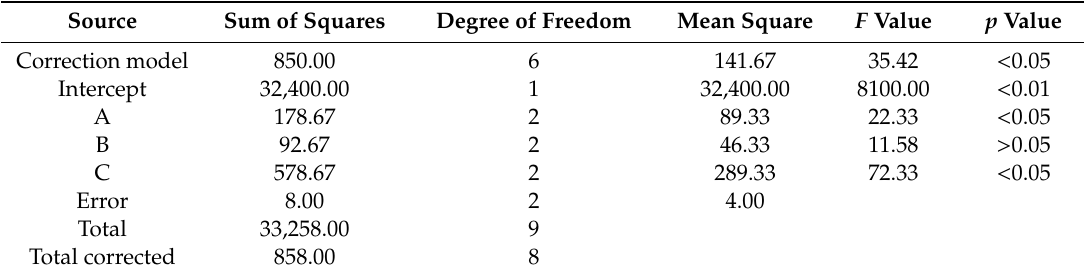
Table 3. Analysis of variance of the physical and chemical properties of the films.